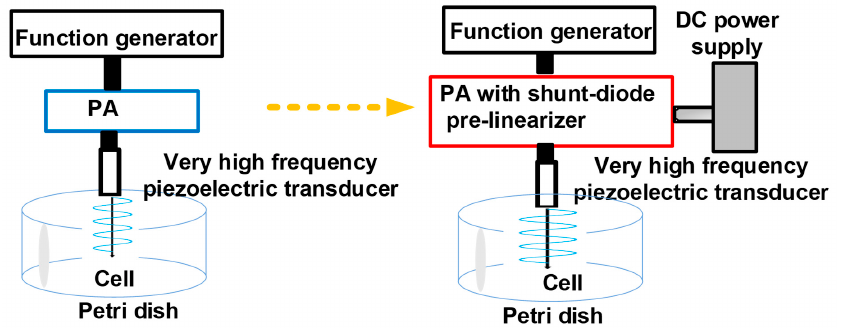
Figure 1. Concept of the acoustic stimulation when using the isolated power amplifier (PA) or PA with shunt-diode pre-linearizer. Especially for very high-frequency piezoelectric transducers, small size tumor cell (<1 cm) treatment could be possible due to the small beam focus of the piezoelectric transducer (<1 cm) [27]. However, very high-frequency piezoelectric transducers produce relatively low-level sensitivity and low detection level compared to low-frequency piezoelectric transducers [13]. In addition, the stable design of the PA working at very high frequency is challenging because high voltage operation and